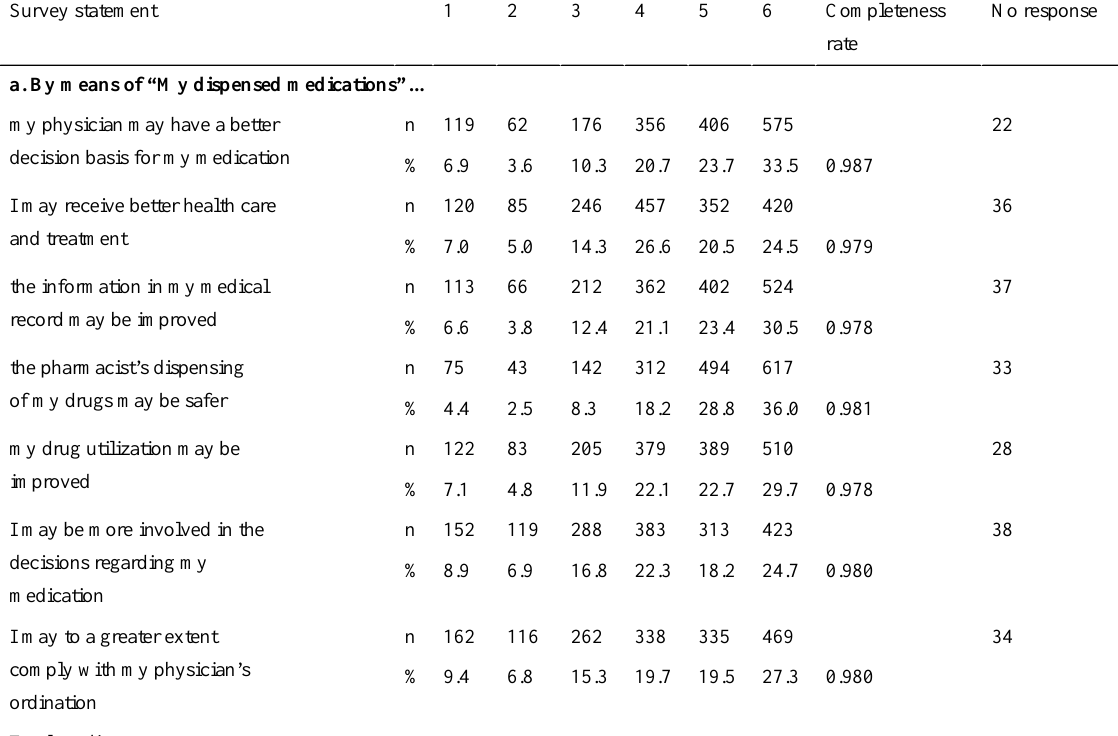
IQRGrade medianNo responseCompleteness rate654321Survey statement